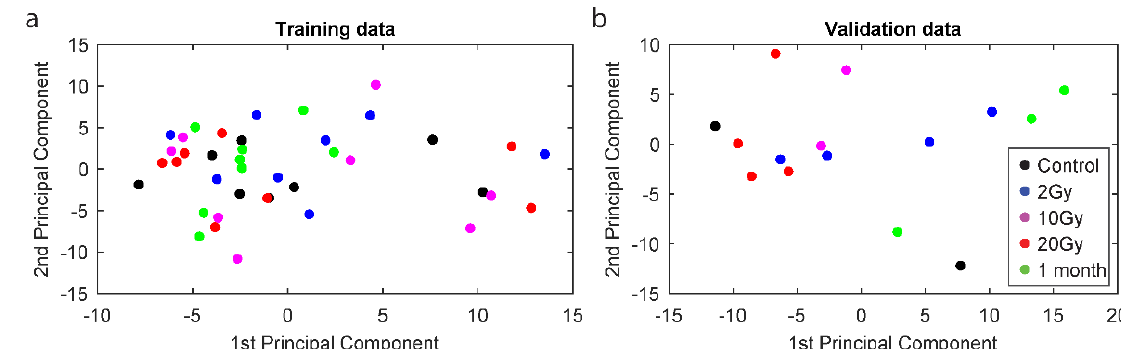
Figure 1. Principal component analysis plot based on 573 miRNAs left after filtering with each dose/collection time point in a different colour. The accumulated dose is shown in all figures, where 10 Gy was given as 5 × 2 Gy, 20 Gy as 10 × 2 Gy, and 1 month represents the time of sampling after reaching, in total, 46–50 Gy, given as 23 or 25 × 2 Gy. Euclidean distance was used. Training sets ( a ) and validation sets ( b ) were analysed separately.